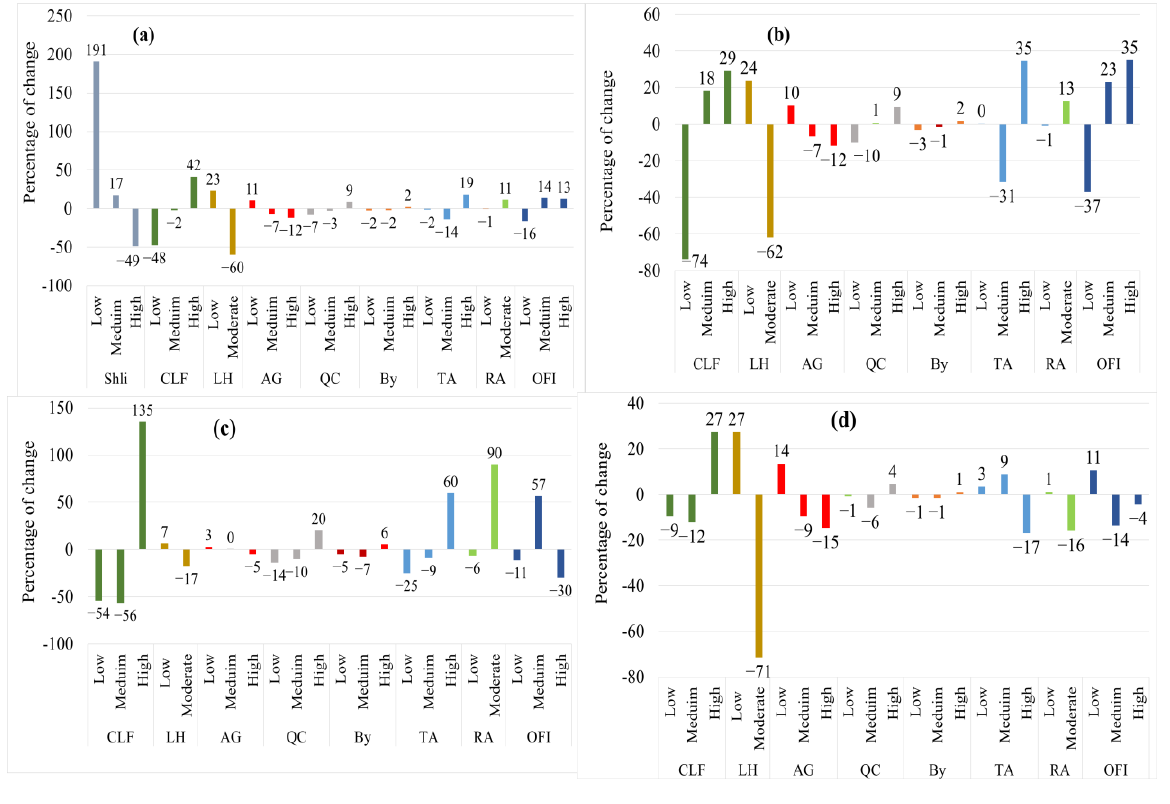
Figure 7. Changes of conditional probabilities of the most relevant variables following scenario S1 ( a ) and change of conditional probabilities for better crop residues use for farms with low livestock income in scenario S2 ( b ), for farms with medium contribution of livestock in scenario S3 ( c ), and for large farm in scenario S4 ( d ).